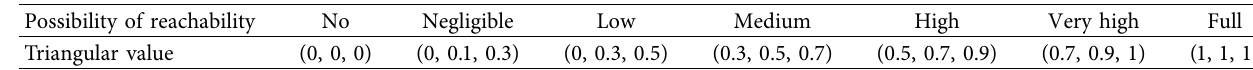
Table 4: 7-point fuzzy scale used in the